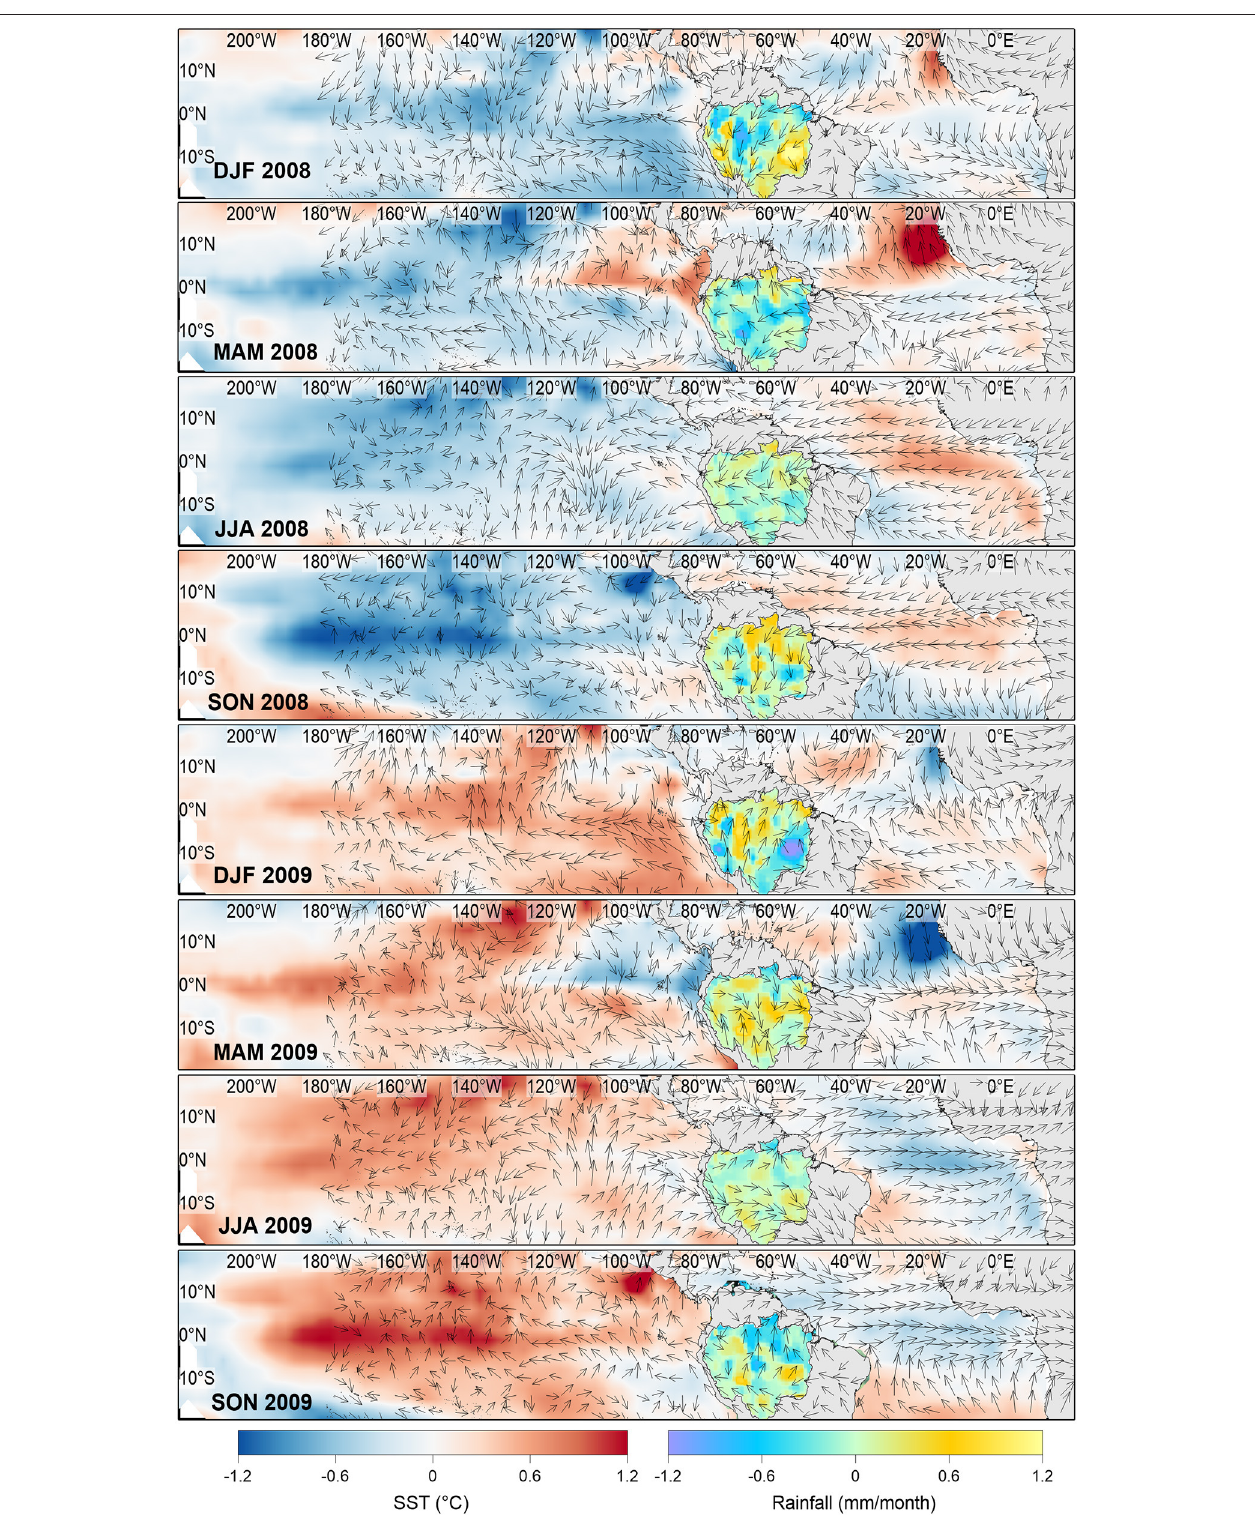
FIGURE 9 | Three-month composites of SST, rainfall (normalized scale by 10 3 ) and surface wind anomalies, from December 2007 to November 2009. Anomalies of SST and rainfall were constructed over the period of 46 years.